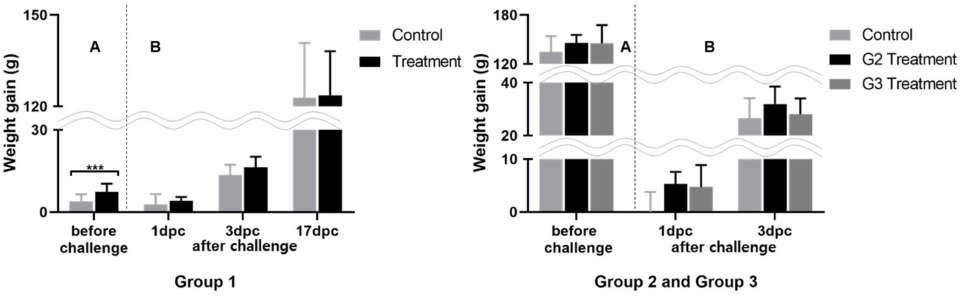
Figure 1. Weight gain differences post LAB administration before and after SE challenge, *** p < 0.001. Table 2. Different schedules of LAB mixture administration and SE re-isolation in chickens. LAB Administration for 3 d LAB Administration for 20